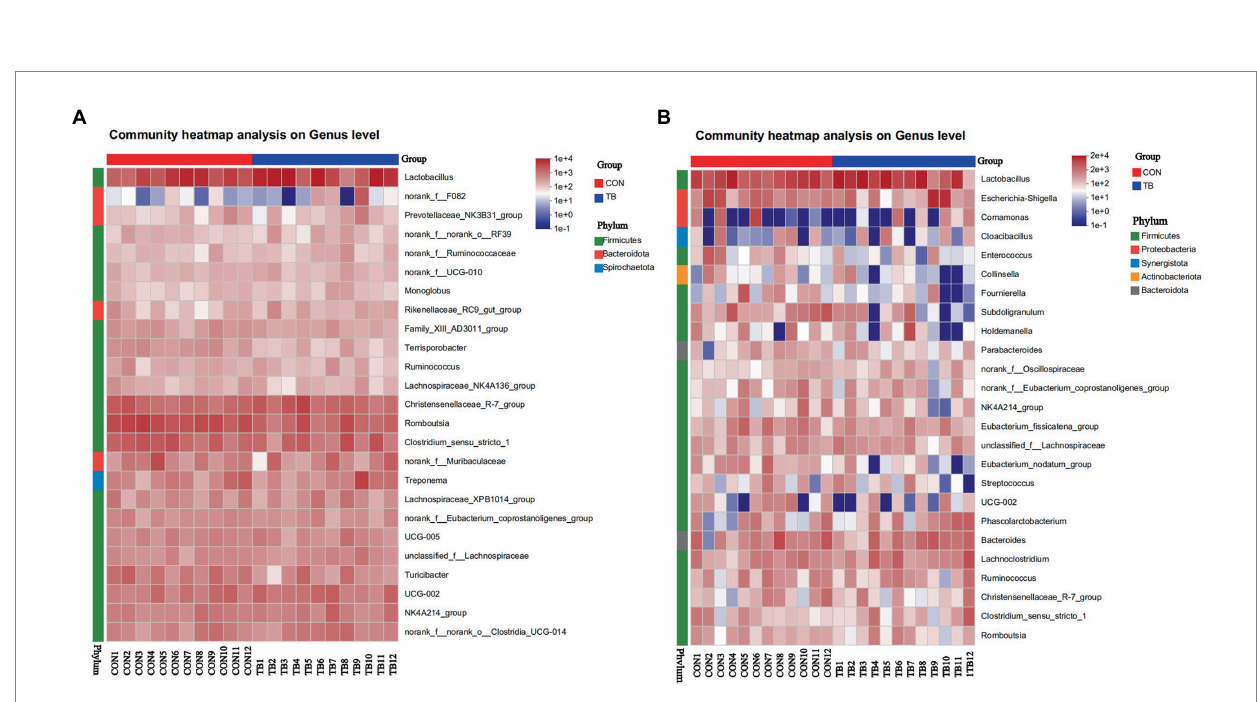
FIGURE 5 Bacterial community heatmap analysis at genus level in sows (A) and piglets (B) . CON (1–12), basal diet; TB (1–12), basal diet +500 g/t tributyrin. The abscissa is the sample name, and the ordinate is the species name. The abundance change of different species in the sample is displayed by the color gradient. The color gradient is shown on the right side of the